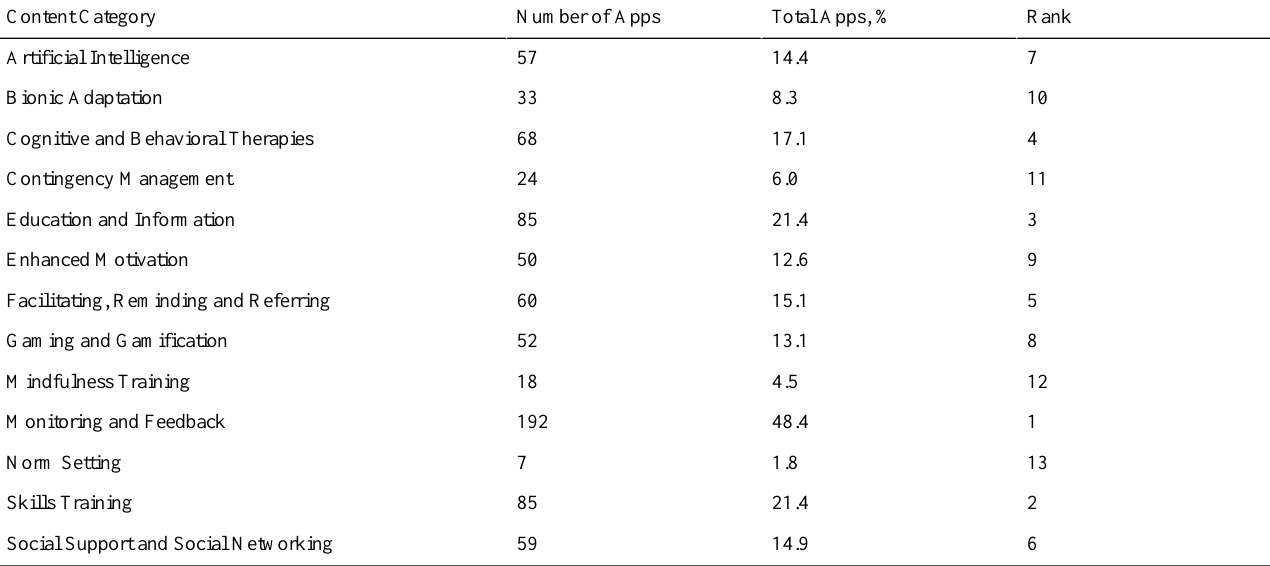
Table 3. Relative emphasis of intervention strategies in NIH-funded smartphone apps